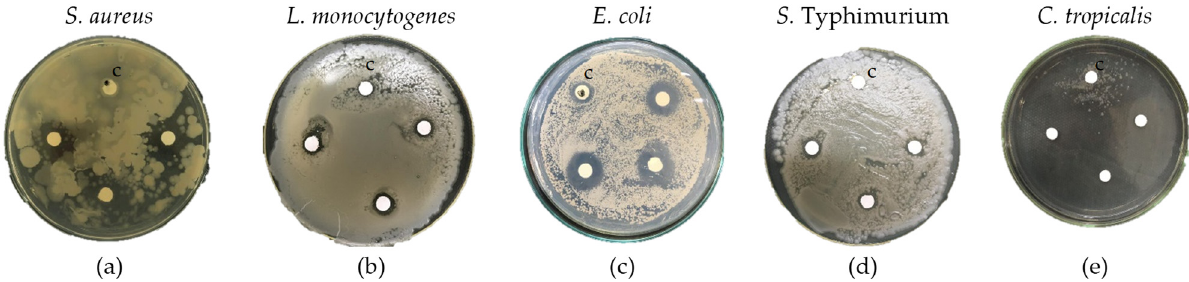
Figure 10. Images of the inhibition halo of VO(IV)- bis (abietate) dispersed in paint (5%) by the diffusion method, tested in triplicate. ( a ) Staphylococcus aureus; ( b ) Listeria monocytogenes; ( c ) Escherichia coli ; ( d ) Salmonella enterica Typhimurium; ( e ) Candida tropicalis . c: disk representing the control (white paint).